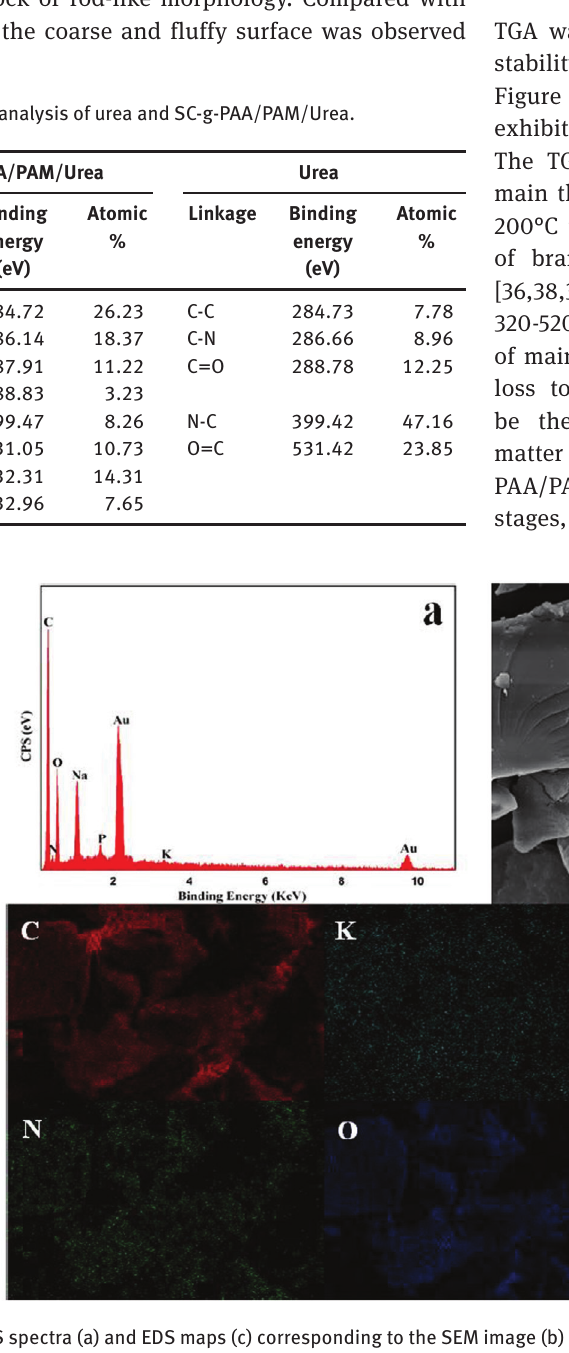
Figure 4: EDS spectra (a) and EDS maps (c) corresponding to the SEM image (b) for surface elemental composition and distribution of